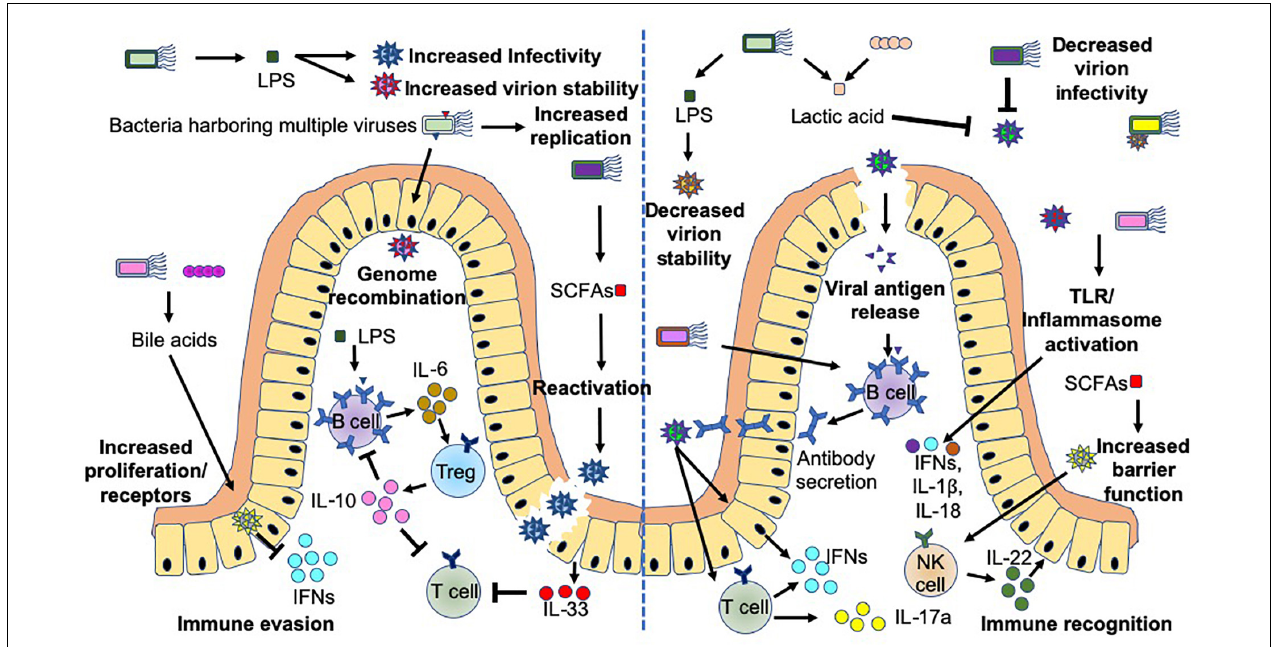
FIGURE 4 | Bacteria-virus crosstalk can promote virus infection or enhance host protection. Interactions between bacteria and viruses can promote infection (left hand-side), or protection of the host (right-hand side) by multiple different mechanisms. These mechanisms focus on alterations to viral stability, replication, genetic recombination, antigen release, mucosal barrier functions and host immunity including cytokine release and antibodies. Bacteria influence viral crosstalk both directly, e.g., Lipopolysaccharide (LPS) binding to the virus or bacterial stimulation of host Toll-like receptor (TLR) or inflammasomes, and indirectly, including through the production of short chain fatty acids (SCFAs e.g., butyrate) or metabolism of bile acids. Additional abbreviations include: IFN (interferons) and IL-